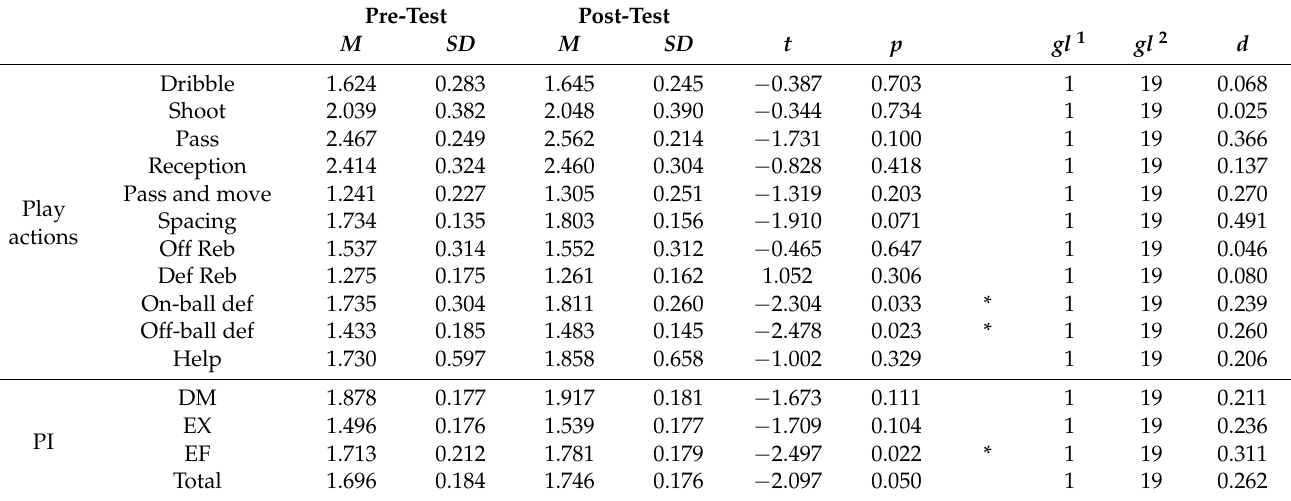
Table 4. T -test for related samples in the DIB